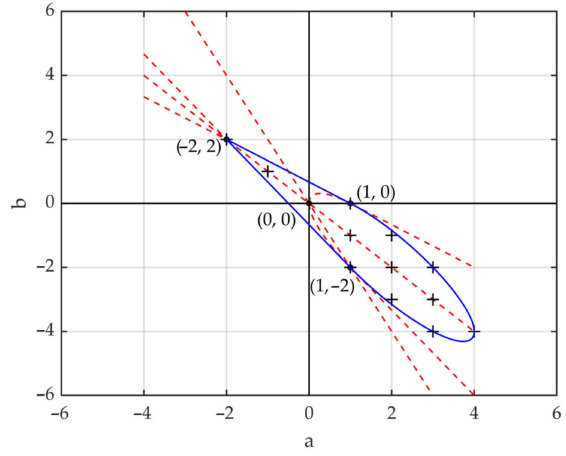
Figure 13. The feasible region of parabola factors a and b. The blue line represents the feasible region, the cross symbols represent the integer feasible solutions, and the bold dots with coordinates denote the solutions of a and b, which correspond to the four crown shapes.